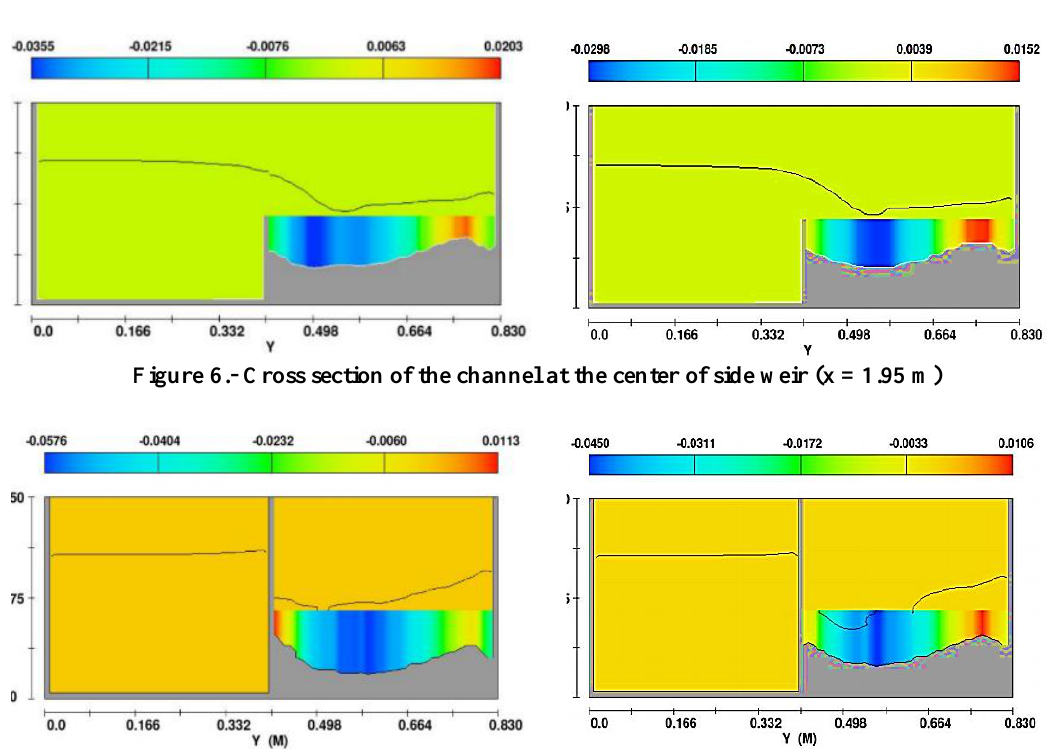
Figure 7. Channel cross section in downstream of side weir (x = 2.1 m)